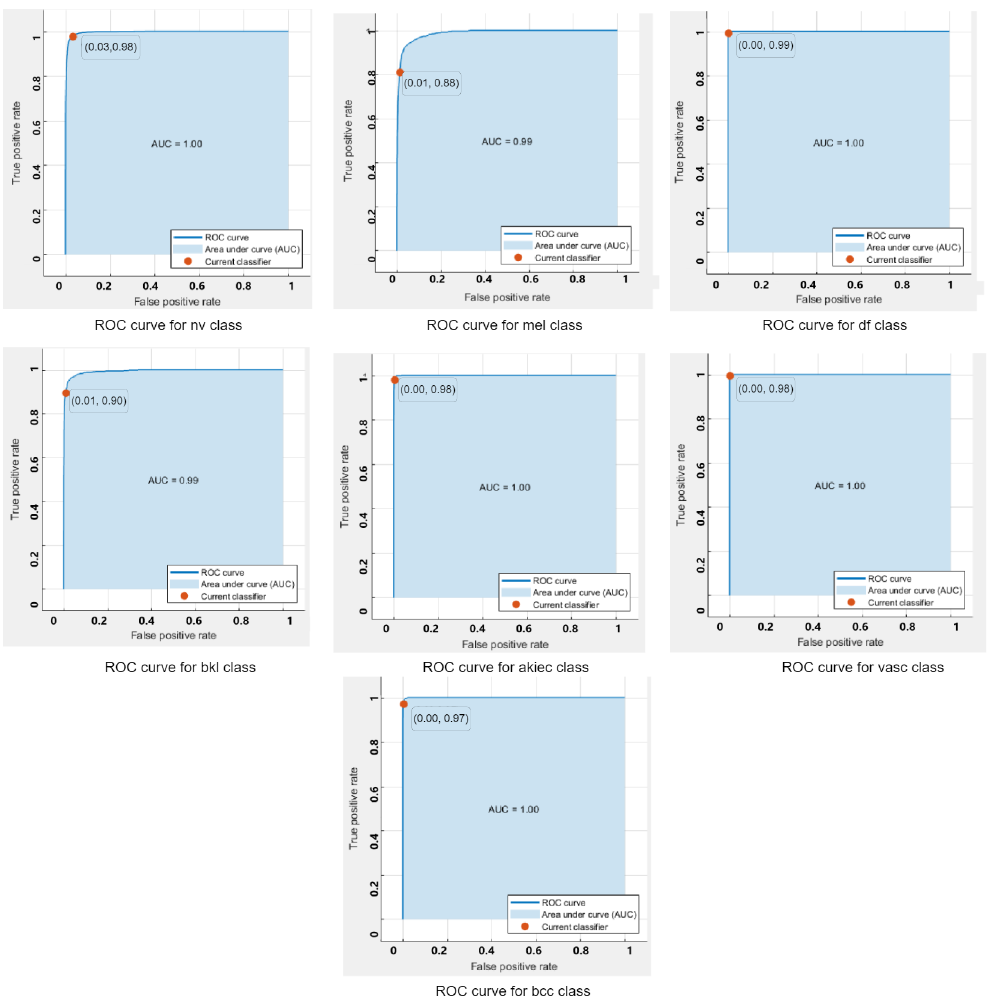
Figure 4. ROC -Curves for each class on SVM.